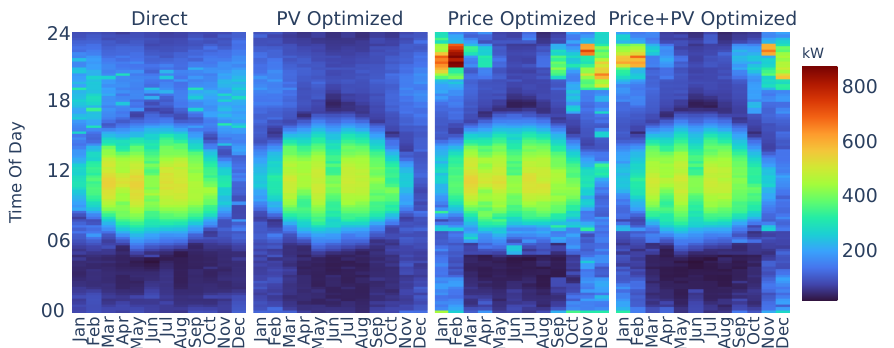
Figure 18. Aggregatedmaximumforgridloadthroughouttheyearforthedifferentcharging configurations. The sizing of lines and transformers in an electrical grid is dependent on the expected maximum loading. Therefore the 1 % maximum values of the grid load are looked at in more detail. Figure 19 depicts the sorted grid load together with the household load and zooms into the 1% largest values. The lines show the highest 1% of the grid load, aggregated over all 100 systems. In comparison, the household load without any EV charging power is shown. The text annotations show the factor by which the grid load is increased by the charging power compared to the household load minus PV for the largest 1% of values.